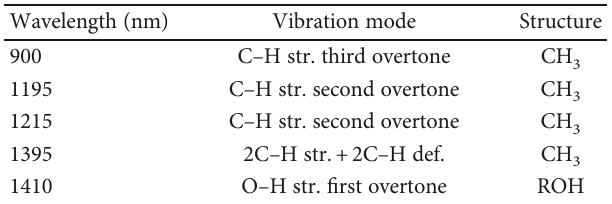
Table 2: Locations of function groups and corresponding vibration modes in the near-infrared